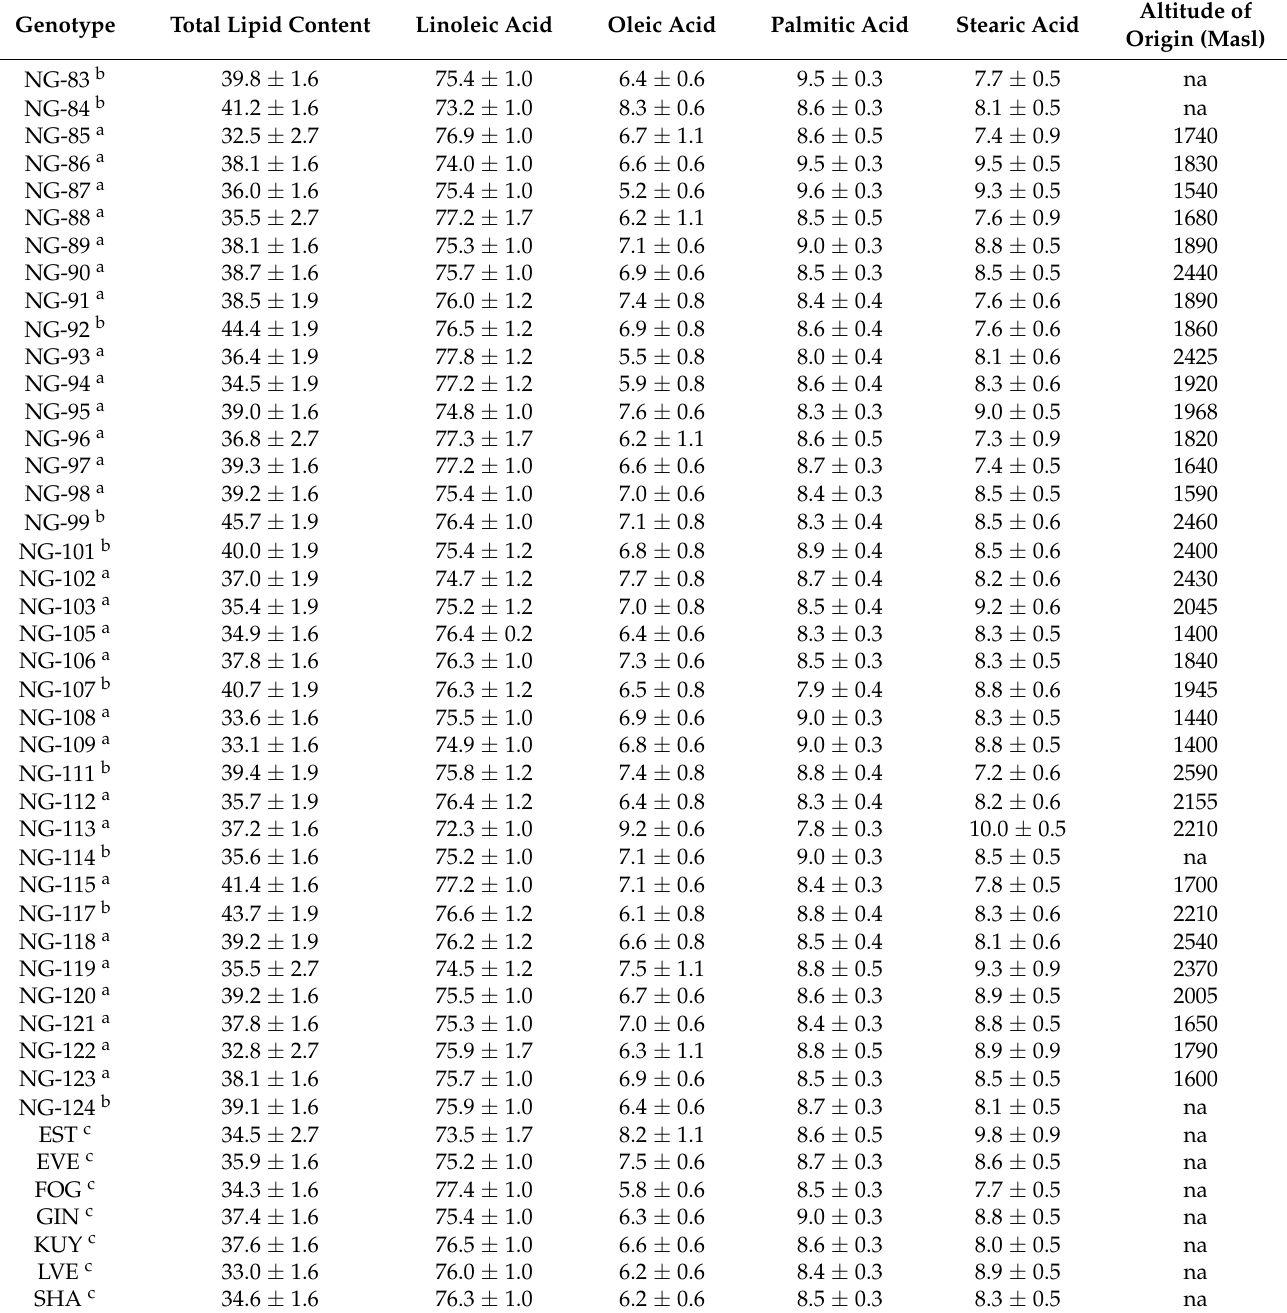
a landrace population, b breeding population, c released cultivar. na = not